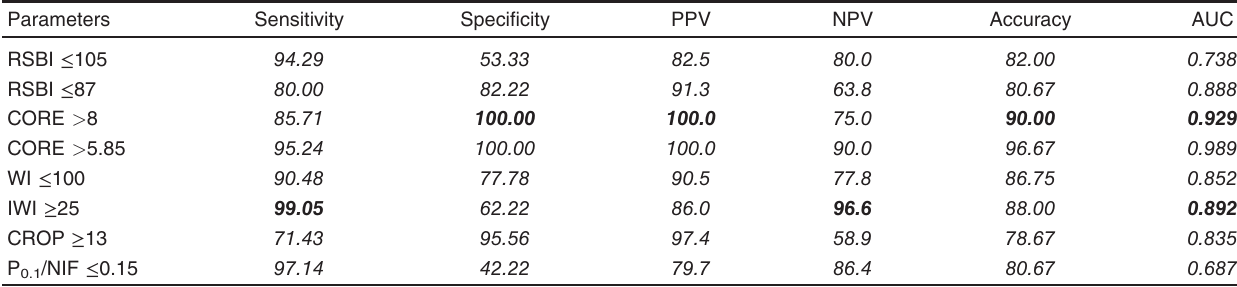
Table 4 Diagnostic test performance of each index used to predict weaning success Parameters